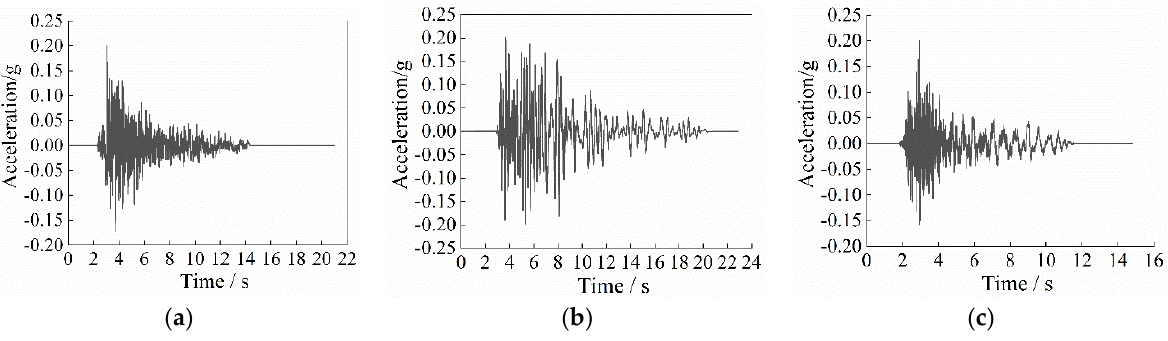
Figure 12. Seismic wave records: ( a ) TAFT wave acceleration time − history curve; ( b ) Hollister wave acceleration time − history curve; ( c ) Cholame wave acceleration time − history curve. Table 7. Loading case for shaking table test.